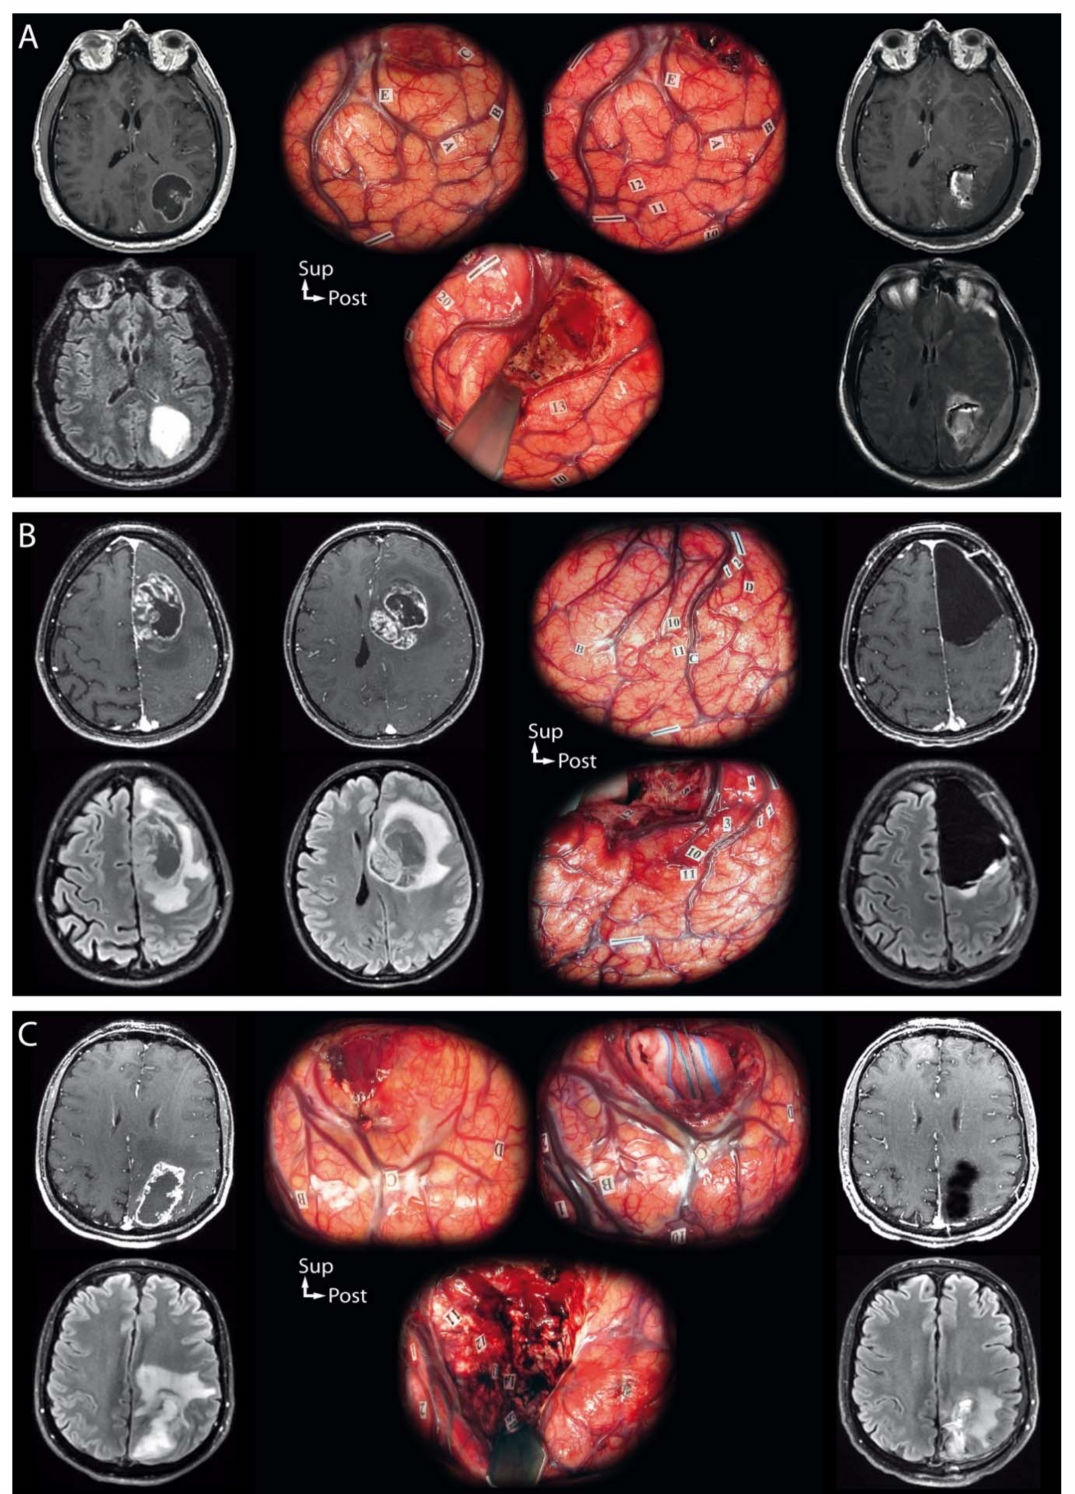
Figure 2. Illustrative cases of the intraoperative management of tumor-related elevated intracranial pressure and local mass effect during awake resection using intraoperative direct cortico-subcortical electrostimulation mapping of IDH -wildtype glioblastomas. On the left, preoperative magnetic resonance examinations (post-contrast T1-weighted and Fluid Attenuated Inversion Recovery sequences); in the middle, intraoperative photographs with eloquent sites tagged; on the right, day-one postoperative magnetic resonance examinations (post-contrast T1-weighted and Fluid Attenuated Inversion Recovery sequences). ( A ) A 63-year-old